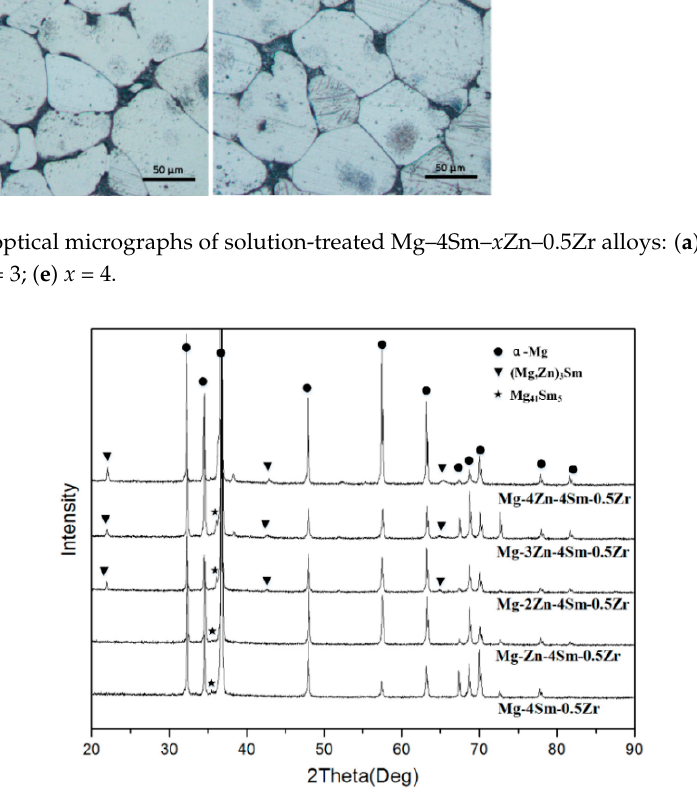
Figure7. The XRD patterns of solution-treated Mg–4Sm– x Zn–0.5Zr ( x = 0, 1, 2, 3, 4) (wt %) alloys.